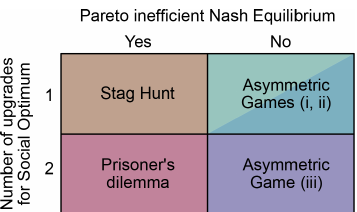
Figure 8. Pareto efficiency and upgrades required for the social op- timum. The five types of dilemmas can be mapped according to whether or not there is a Nash equilibrium that is Pareto inefficient and the number of players that would have to upgrade to achieve a social optimal outcome (PD and AD games). In the stag hunt game, if one player can be convinced to upgrade, then the other player will be incentivized to upgrade as